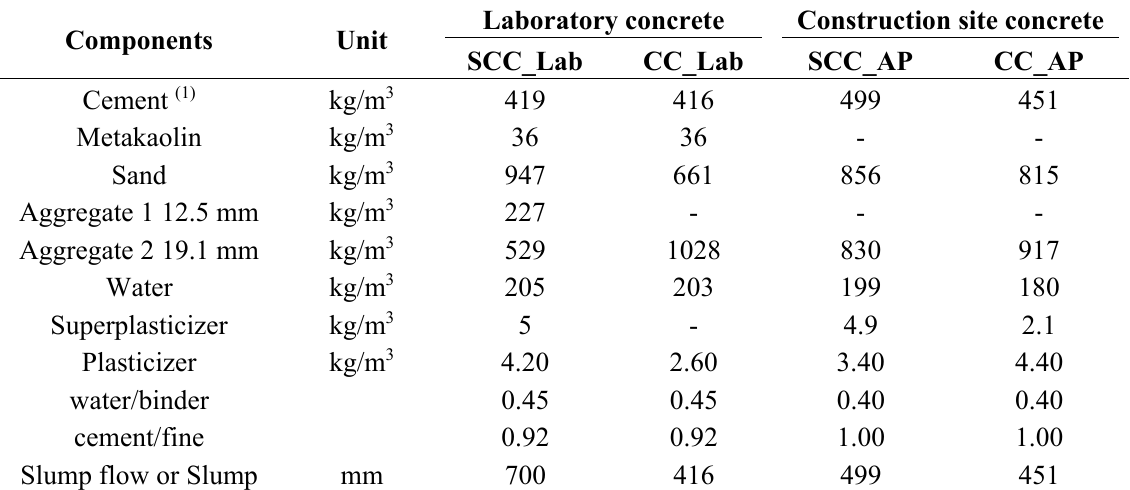
Table 1. Compositions of SCC and CC.